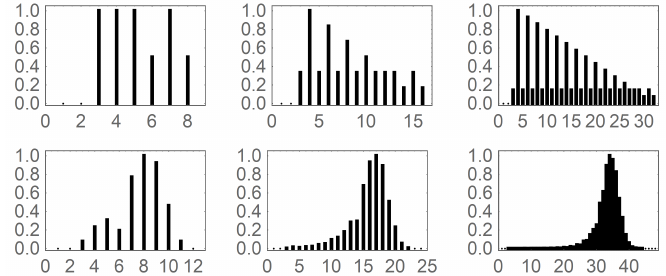
Figure 24. The normalized cycle spectrum for products of powers of two and one odd prime. The cases of p = 2 m · 3 ( top row ) and p = 2 m · 5 ( bottom row ) where m =